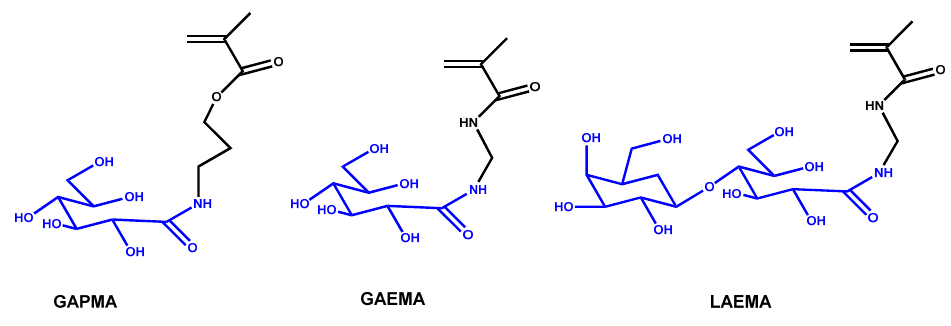
Figure 9. Different glycomonomer